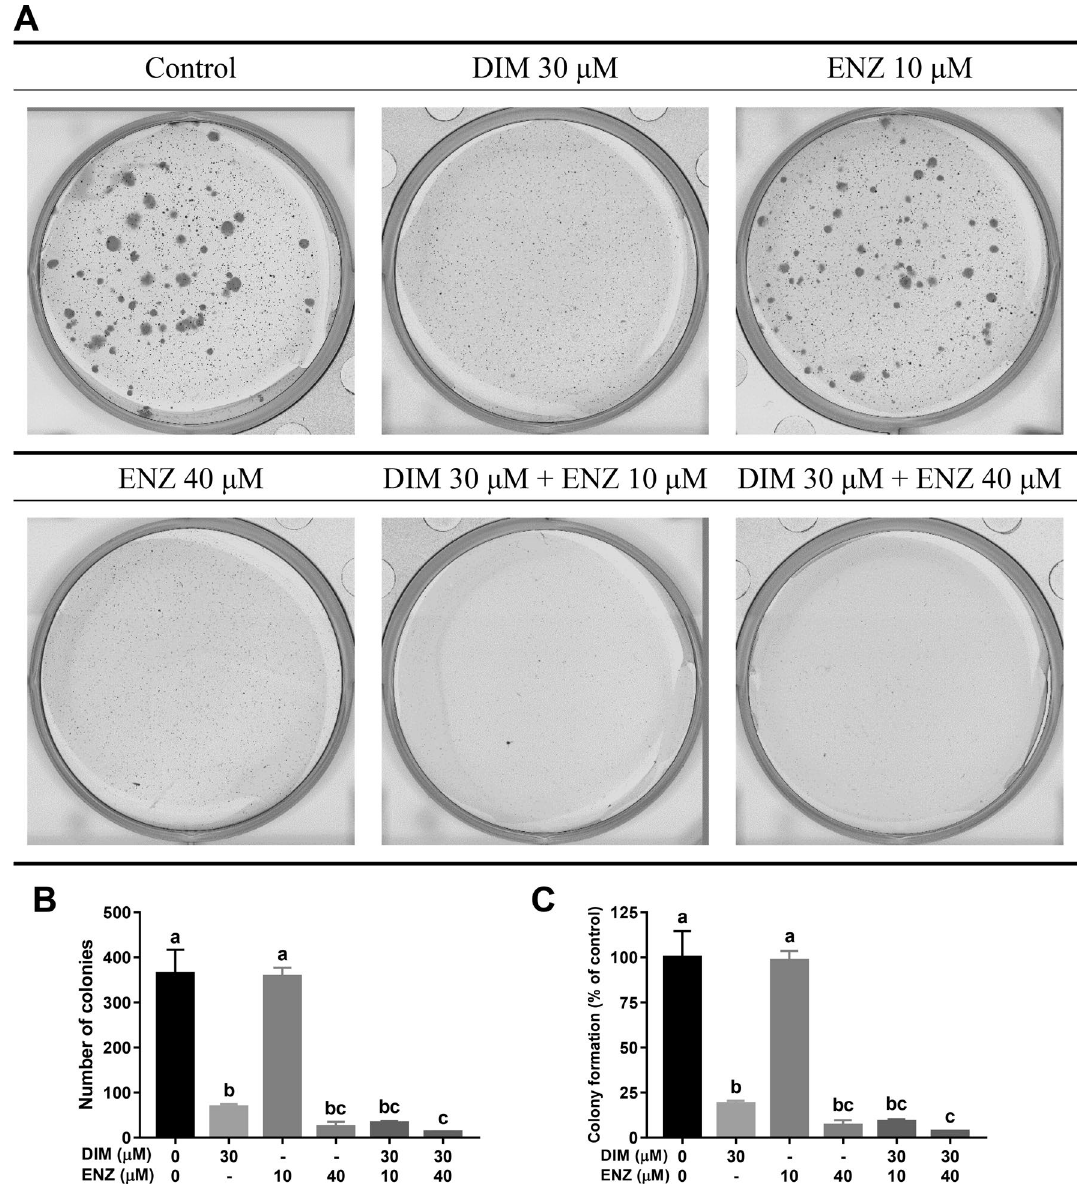
Figure 2. DIM and ENZ treatment suppress cell colony formation of PCa cells (n = 3). DIM 3,3 ′ -diindolylmethane; ENZ enzalutamide. Representative images ( A ), number of colonies ( B ), colony formation normalized to control ( C ). Values are presented as means ± SD. a,b,c Bars without the same letters at the top indicate statistically-significant differences between treatments when compared with each other (one-way ANOVA, Duncan’s new multiple range test, p < DIM and ENZ treatment alter EMT‑related mRNA and protein expressions in PCa cells. The process of EMT plays a pivotal role in CRPC and is related to drug resistance. Moreover, Wnt signaling and AR signaling activate EMT in CRPC. To investigate the role of EMT in CRPC, qPCR was performed to examine the mRNA expressions of an epithelial marker (E-cadherin, CDH1) and mesenchymal markers (Fibronectin and Vimentin, FN1 and VIM). After treatment for 48 h, exposure to DIM or ENZ alone, and combined treatment with DIM and ENZ, significantly upregulated the expression of CDH1 (Fig. 8A; p < 0.05 vs. control). On the other hand, cells treated with DIM alone and co-treated with DIM and ENZ exhibited significantly decreased expressions of FN1 and VIM , but cells treated with 10 μM ENZ alone exhibited a significantly increased expres- sion of FN1 (Fig. 8A; p < 0.05 vs. control). Exposure to 40 μM ENZ significantly downregulated the level of FN1 but increased the expression of VIM (Fig. 8A; p < 0.05 vs. control). Compared with treatment of 22Rv1 cells with 10 μM ENZ alone, co-treatment with ENZ and DIM significantly upregulated the level of CDH1 and downregu- lated the levels of FN1 and VIM (Fig. 8A; p < 0.05 vs. 10 μM ENZ).